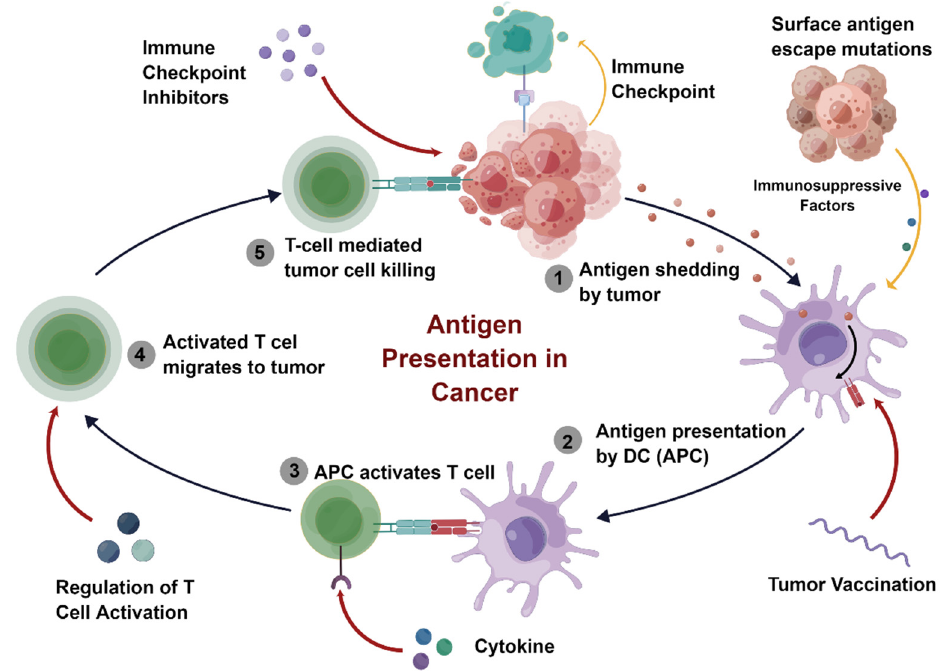
Figure 6. The cancer antigen-presenting machinery and the involvement of nanoparticles in the antitumor immunity pathway (this figure was created By Figdraw). Dendritic cells capture antigens to present them to T cells, leading to T-cell activation. Activated T cells target and kill tumor cells. Tumor tissue can affect DC presentation through the secretion of immunosuppressive factors and the role of immune checkpoints in suppressing T cells. Nanoparticles can promote DC and T-cell activation by delivering tumor vaccines, cytokines, etc., which can promote the presentation of tumor antigens. At the same time, the antitumor effect of T cells can be enhanced by delivering immune checkpoint inhibitors.